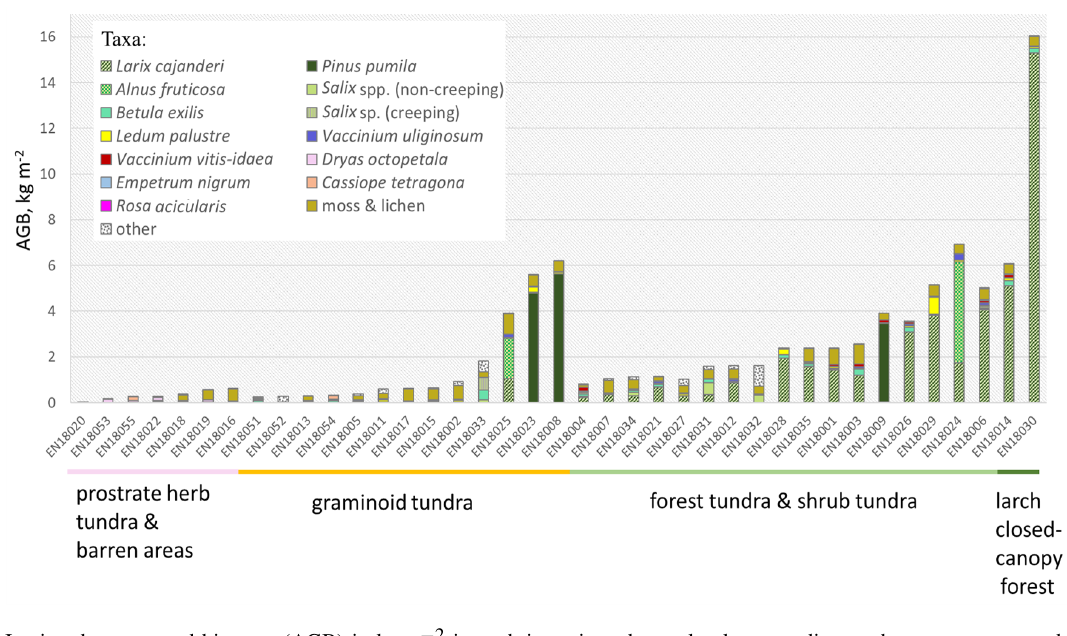
Figure 4. In situ above-ground biomass (AGB) in kgm − 2 in each investigated sample plot according to the taxa present, ordered by the predicted land-cover class (below names of the sample plots).